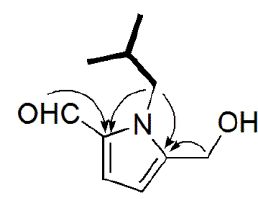
Figure 1. Structures of compounds 1 – 7 .